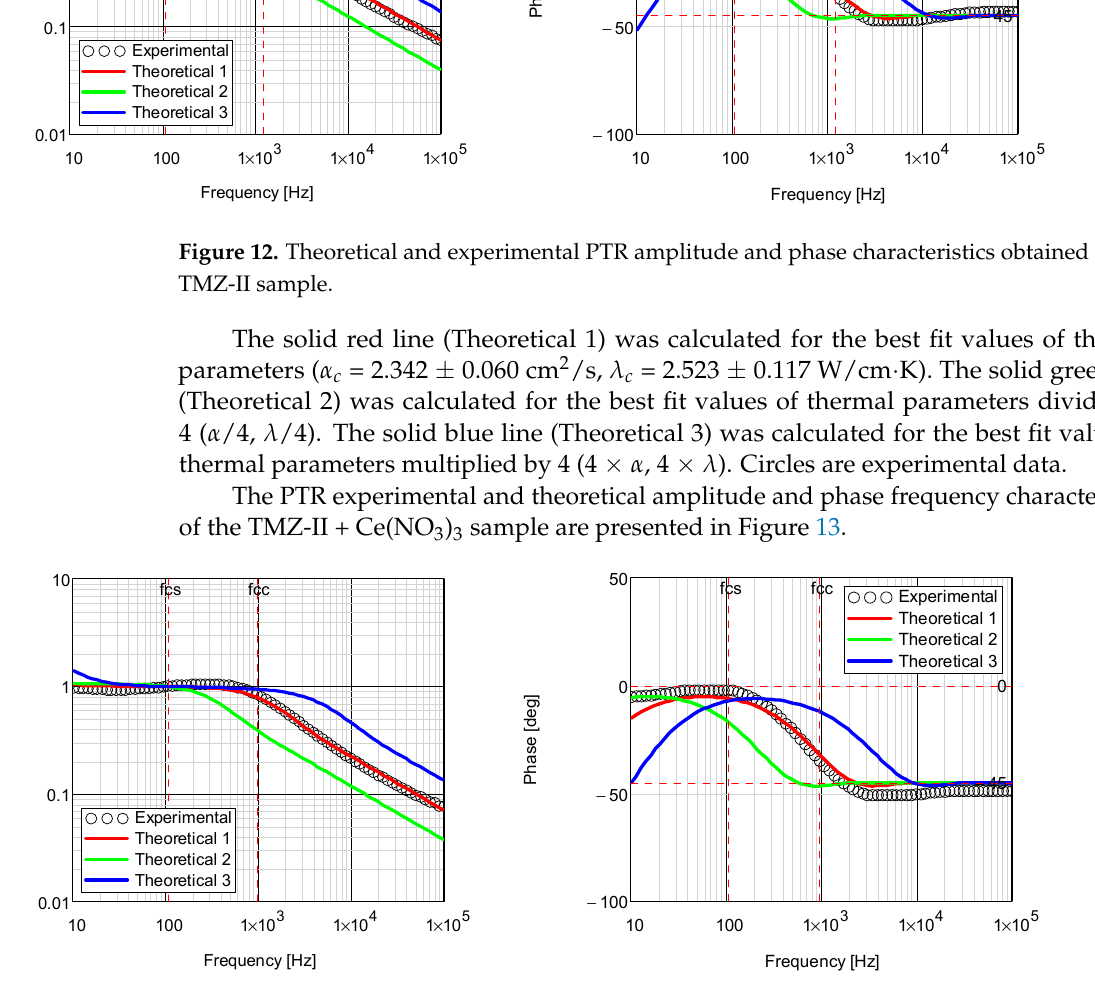
Figure 13. Theoretical and experimental PTR amplitude and phase characteristics obtained for the TMZ-II + Ce(NO 3 ) 3 sample. The solid red line (Theoretical 1) was calculated for the best fit values of thermal parameters ( α c = 1.960 ± 0.082 cm 2 /s, λ c = 1.900 ± 0.250 W/cm · K). The solid green line (Theoretical 2) was calculated for the best fit values of thermal parameters divided by 4 ( α /4, λ /4). The solid blue line (Theoretical 3) was calculated for the best fit values of thermal parameters multiplied by 4 (4 × α , 4 × λ ). Circles are experimental data. The PTR experimental and theoretical amplitude and phase frequency characteristics of the TMZ-III sample are presented in Figure 14.